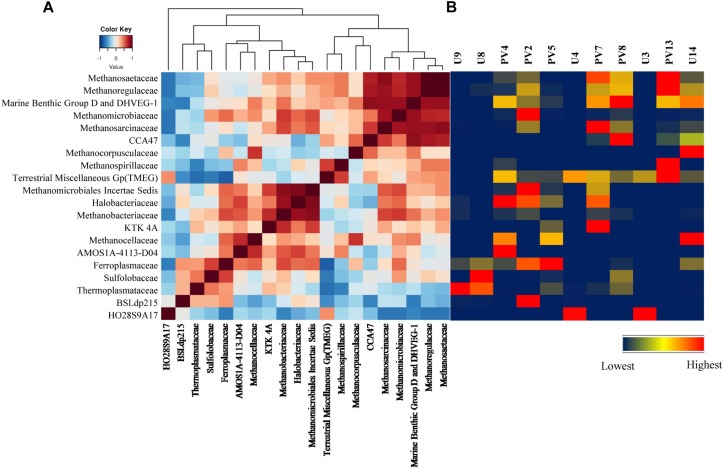
Correlation among different microbial classes. (A) Heatmap of Spearman correlation across archaeal families. (B) Heatmap of relative percentage abundance of corresponding archaeal classes across all the samples.